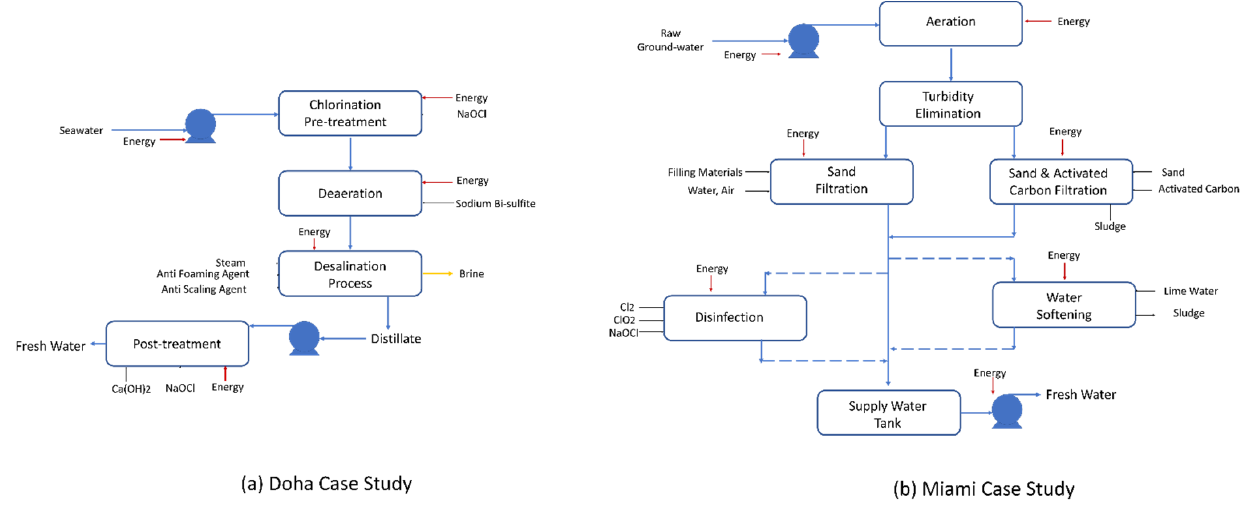
Figure 4. Simplified diagram of water treatment system in Doha ( a ) and Miami ( b ). In Doha seawater desalination is the primary source of water for residential buildings while groundwater treatment acts as the main source for Miami.